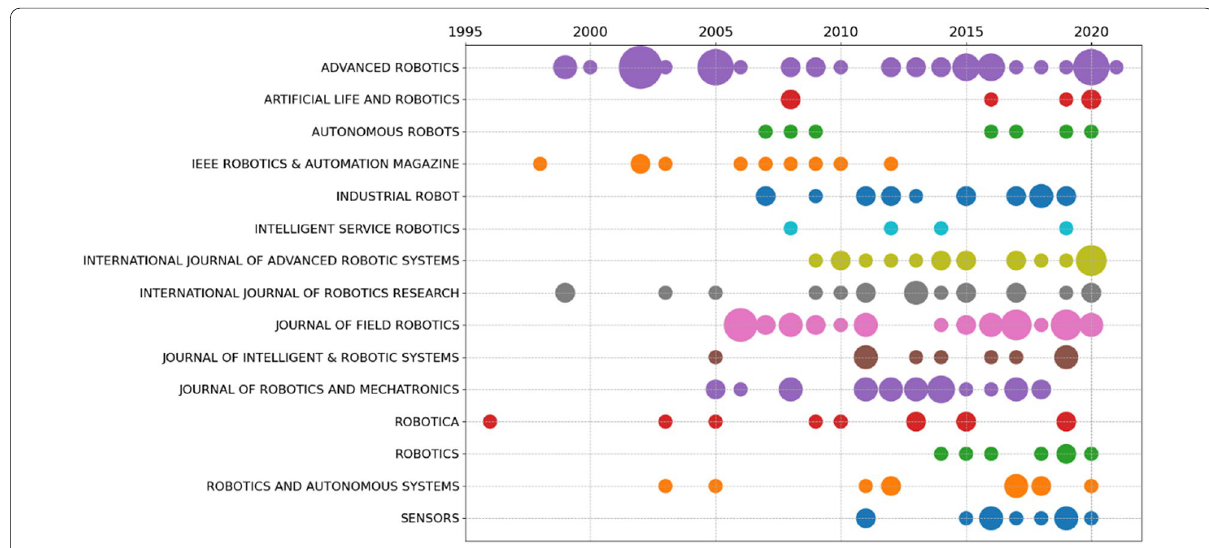
Fig. 4 Productivity of top 15 journals published RR articles in